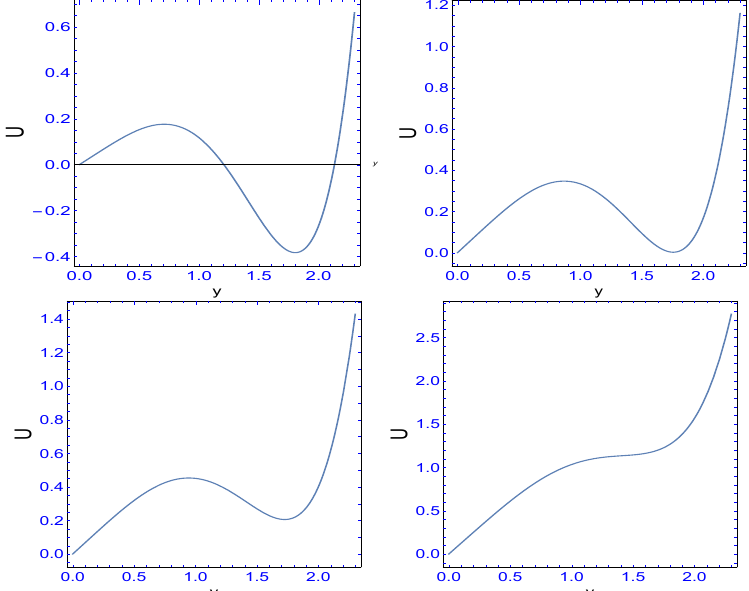
Figure 10. Shown are four cuts of the potential at a = 0.5 m 0 and, respectively from upper left to lower right, for the values of ( n = 4) b n = 2, 3.3, 4 and 7.5. For b n = 2, the deformed minimum is at negative values; for b n = 3.3, it is at the same height as for U at y = 0, for b = 4, the deformed minimum is at positive values and, at 7.5, it is disappearing, being close to the point where the maximum and minimum join, as shown in Figure 9. For the potential, (27) was used. The corresponding